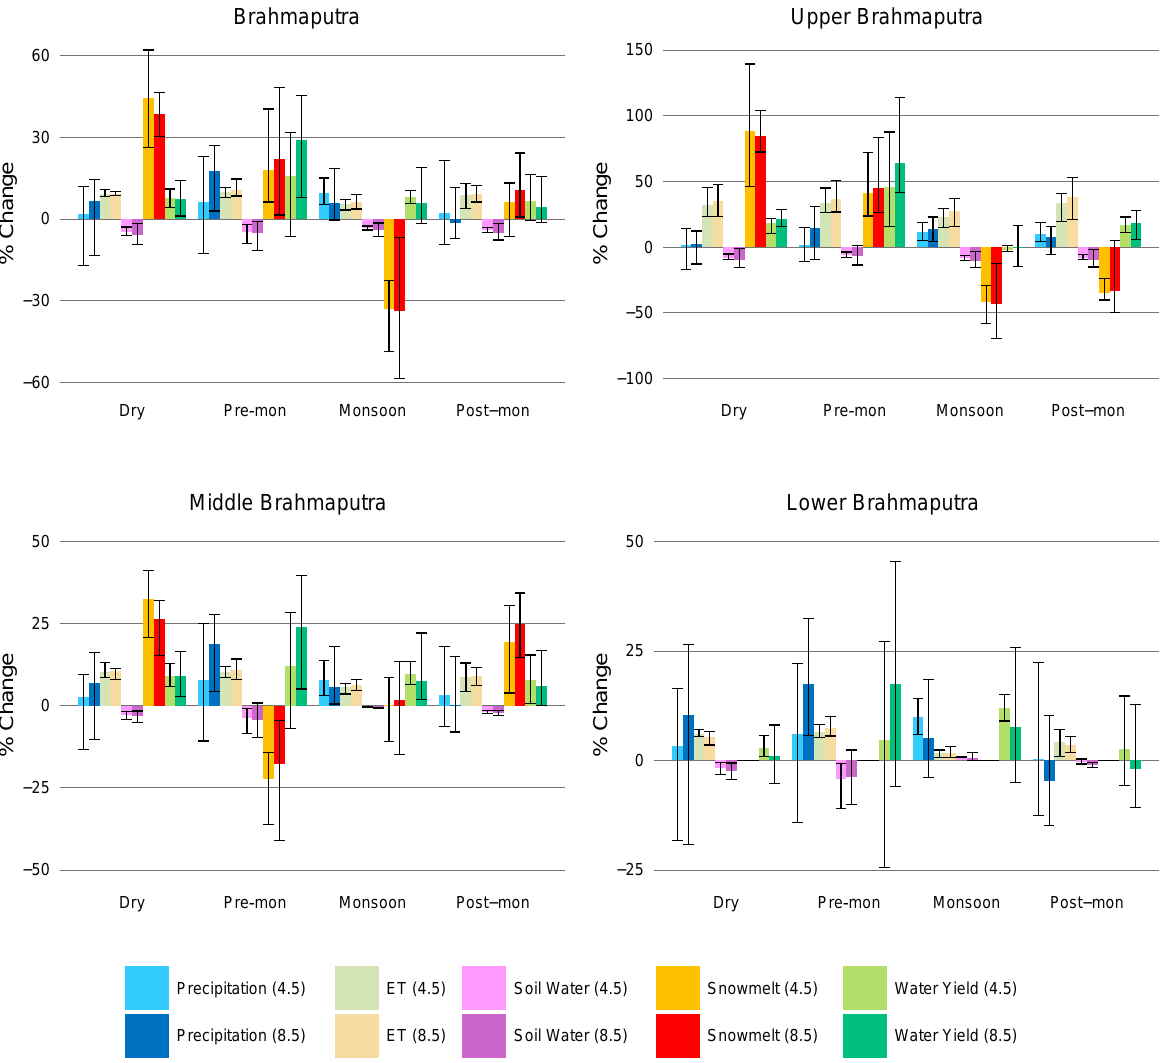
Figure 15. Season-wise average impact of climate change on five key water balance components (bars) in the whole Brahmaputra basin and three regions; error bars show the range of values (maximum and minimum) projected under the four climate